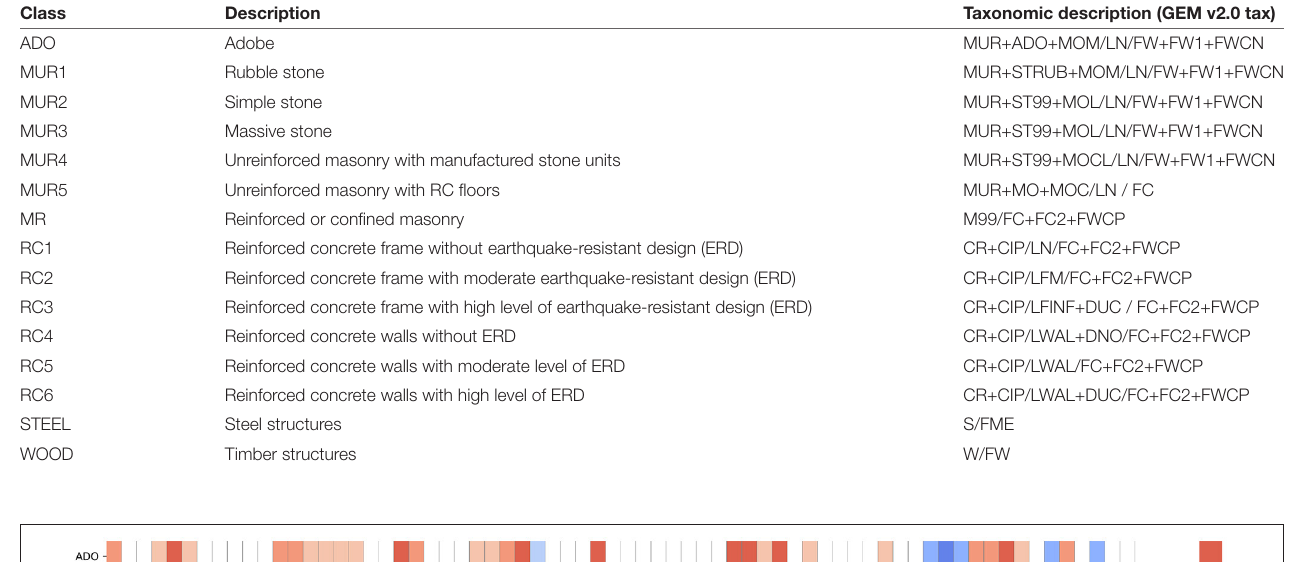
TABLE 5 | Building classes defining the EMS-98 scheme.